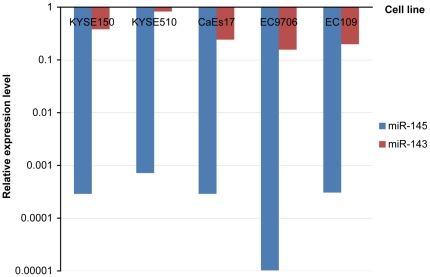
Relative expression of miR-143 and miR-145 in ESCC cell lines.Red bar and blue bar represent the relative expression of miR-143 and miR-145 normalized by U6 in five ESCC cell lines respectively. The correlation analysis suggested a co-expression pattern between miR-143 and miR-145.